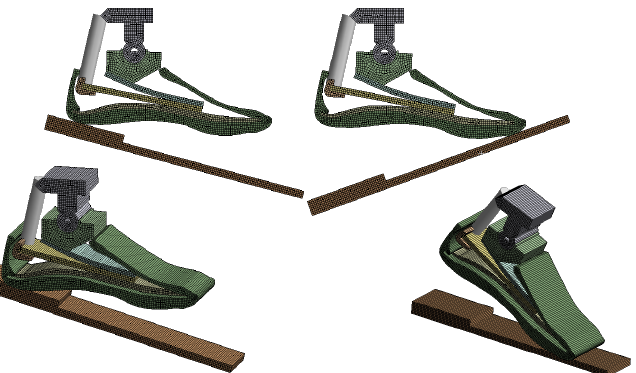
Figure 6. Mesh modeling and width assignment in the transversal direction. The 2D FE model was meshed with PLANE183 elements, for a total of 10,000 nodes without the platform and 20,000 with the